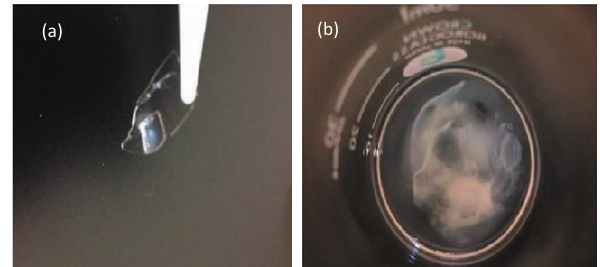
Figure 5. These photographs illustrate that the polyamplolytic hydrogels formed without the use of chemical crosslinking agents formed clear plastic fi lms when dry (a) and then when equilibrated with excess water (b), the polymer chains completely dispersed.